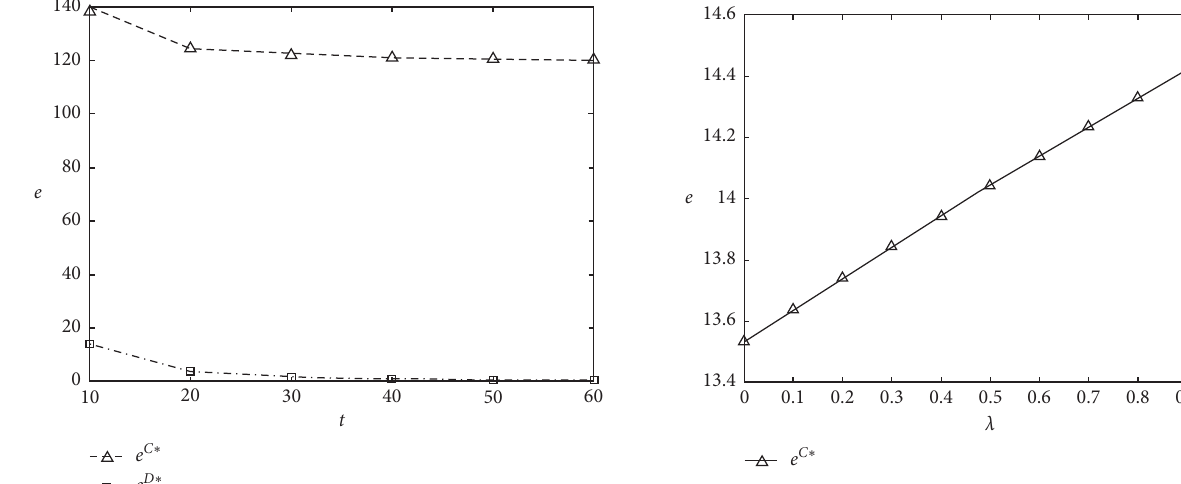
Figure 3: The effect of risk aversion coefficient on fresh-keeping effort. Figure 1: The effect of time on preservation effort.